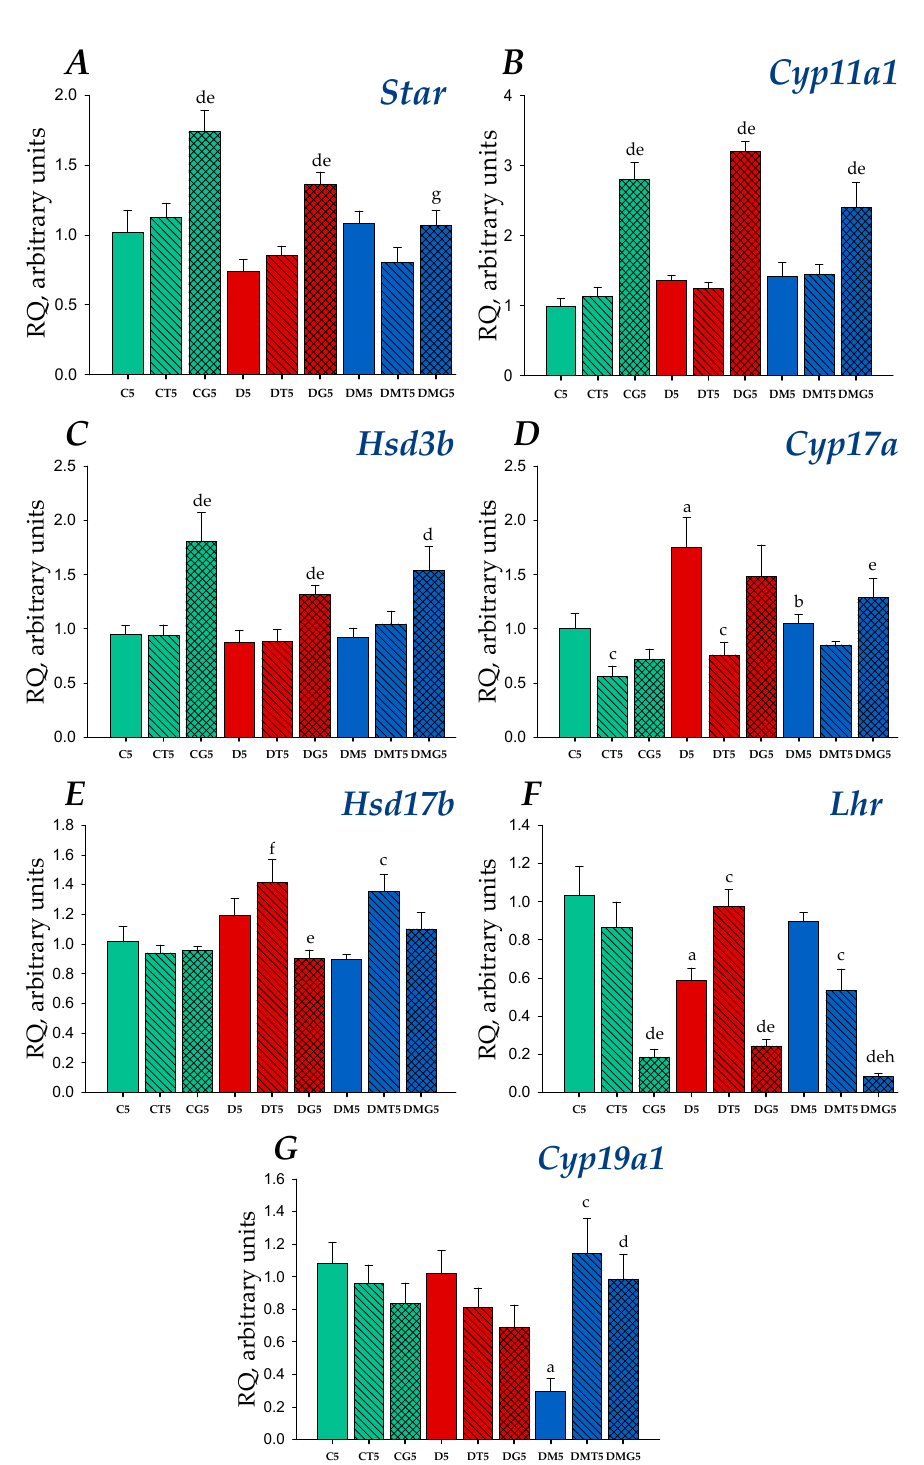
Figure 4. The influence of five-day treatment with hCG and TP3 on the expression of testicular genes encoding cholesterol-transporting protein StAR, steroidogenic enzymes and LH/hCG-R in the control and diabetic rats, and the effect of five-week metformin treatment. The duration of MF treatment (120 mg/kg/day) was five weeks. The samples for the assessment of gene expression in the testes were taken 5 h after the last injection of LH/hCG-R-agonists. The expression of the following genes is shown in the Figure: Star , encoding cholesterol-transporting protein StAR ( A ); Cyp11a1 ( B ), Hsd3b ( C ), Cyp17a1 ( D ) and Hsd17b ( E ), encoding four steroidogenic enzymes